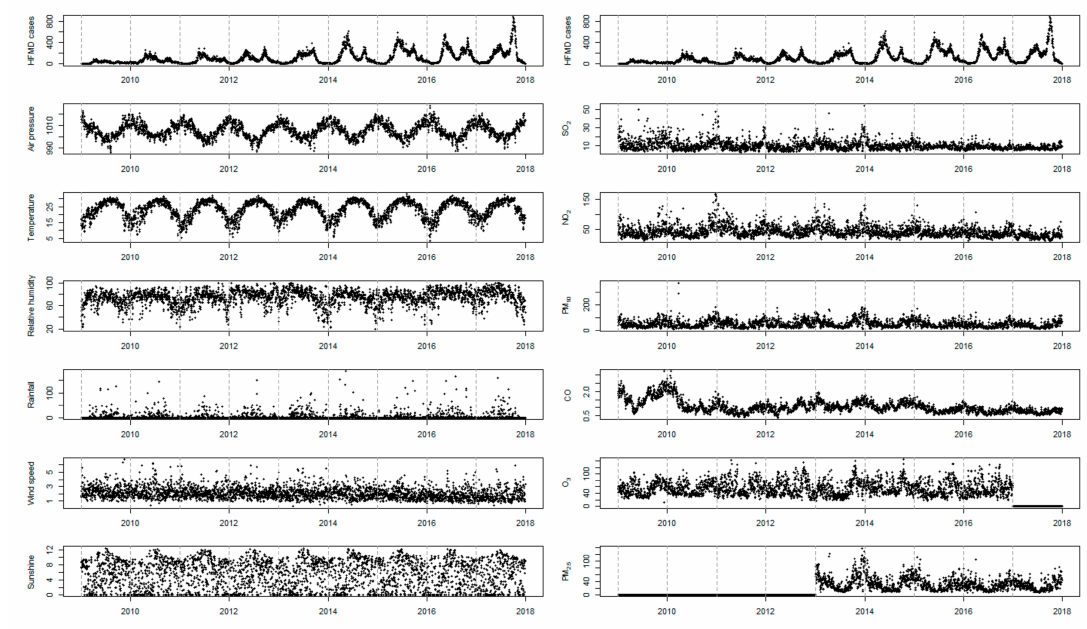
Figure 1. Daily distribution of children HFMD cases, meteorological variables and air pollutants